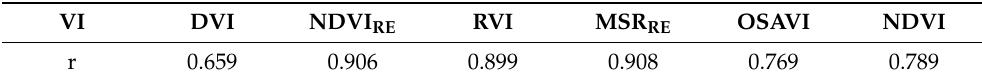
Table 4. Correlation analysis results between VIs and in situ